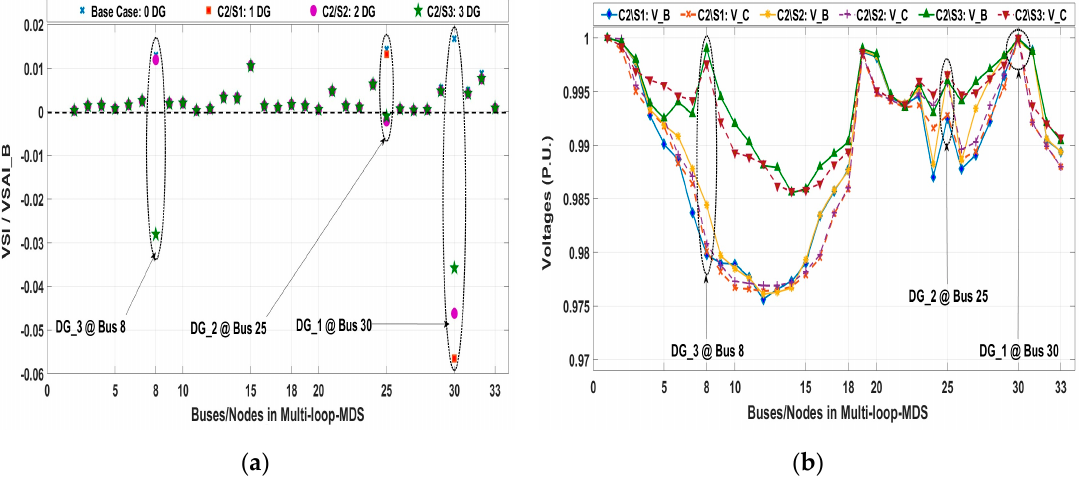
Figure 7. Case 2 for 33-bus MDS: All DGs are type-2 and operating at 0.90 ± 3% PF ( a ) VSAI_B trend, ( b ) V_B profile trend as feasible solution of VSAI_B and calculated V_C profiles.